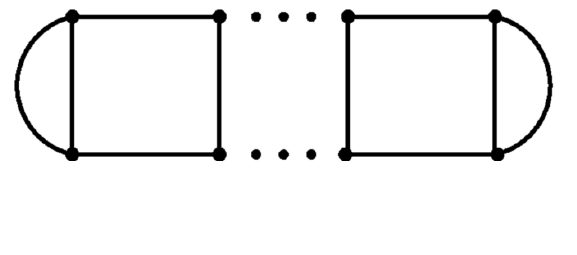
Figure 9. Hyperelliptic